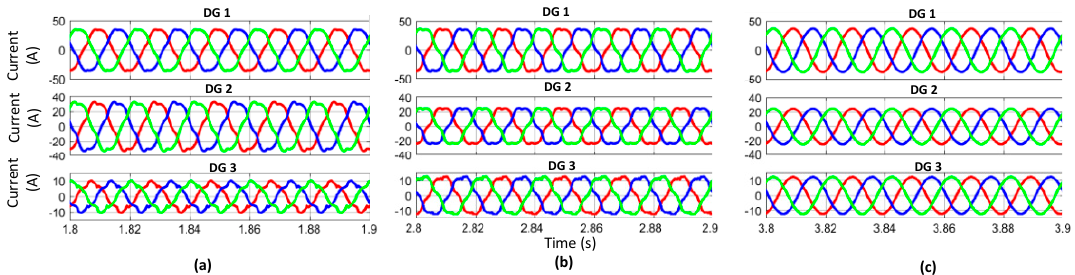
Figure 8. Current waveforms of DGs in various steps for the harmonic compensation from left to right. ( a ) First step (without harmonic current compensation); ( b ) second step (with harmonic current compensation); ( c ) third step (enabling the APF).